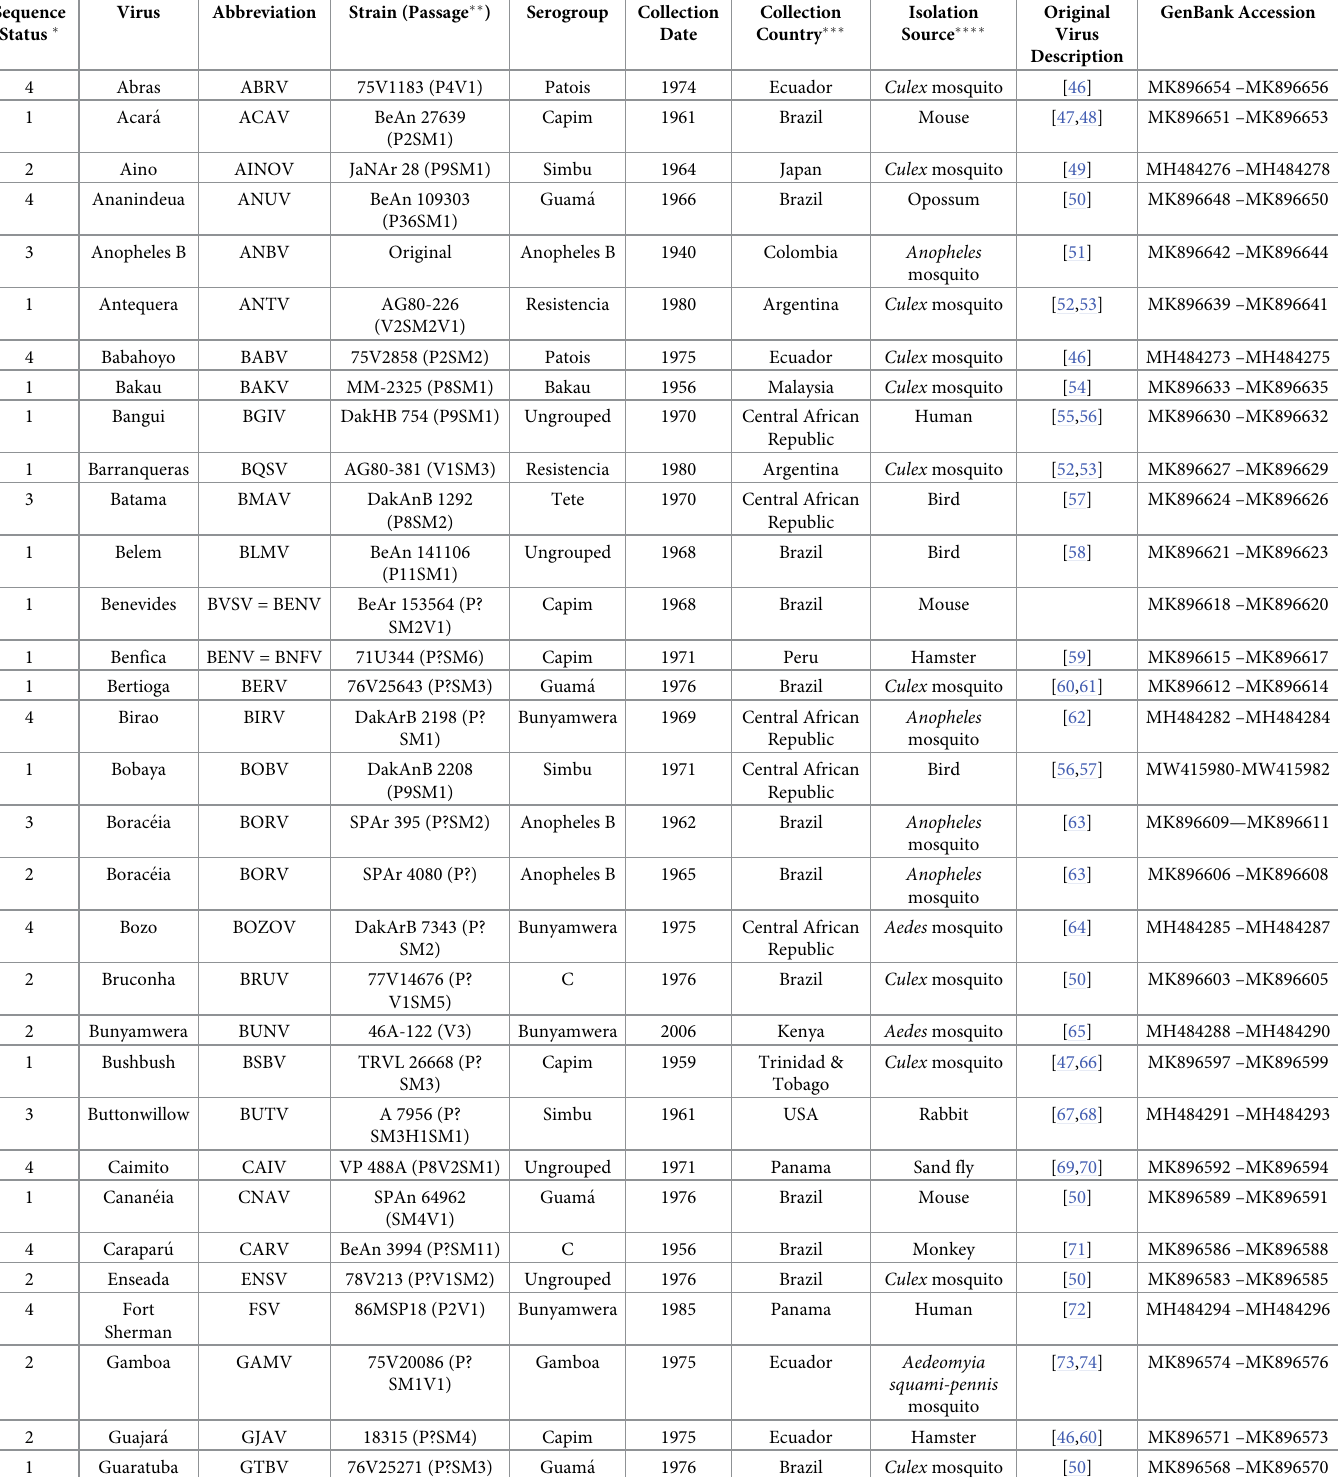
Table 1. Sequenced genomes of 88 viruses belonging to Peribunyaviridae (Orthobunyavirus or Pacuvirus) . Sequence Status